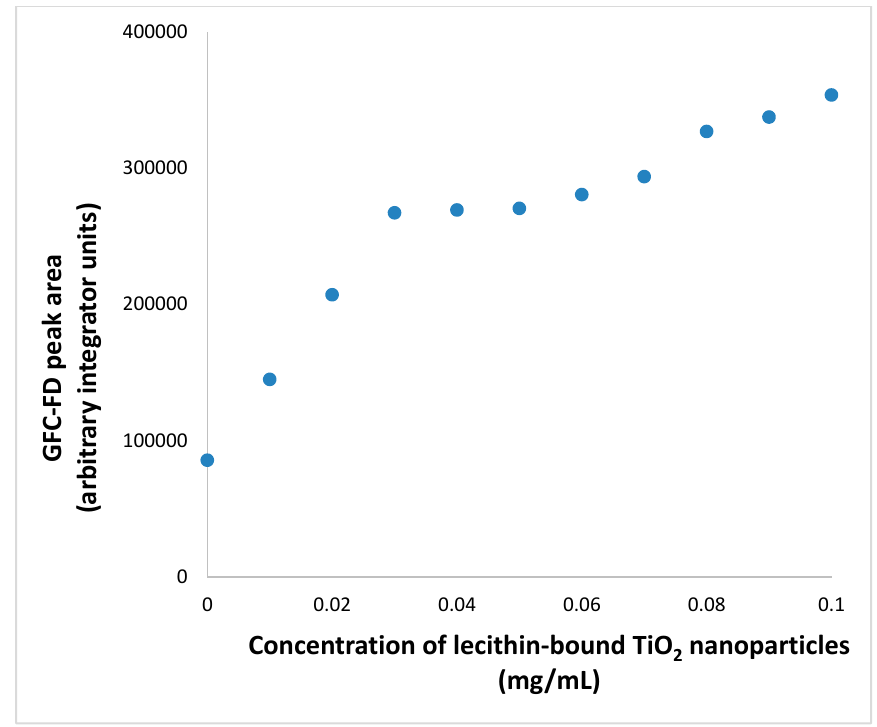
Figure 9. Standard calibration curve for extended GFC analysis of lecithin liposome-encapsulated TiO 2 nanoparticles at a flow rate of 1 mL/min, using λ ex,max = 350 nm and λ em,max = 395 nm for FD.